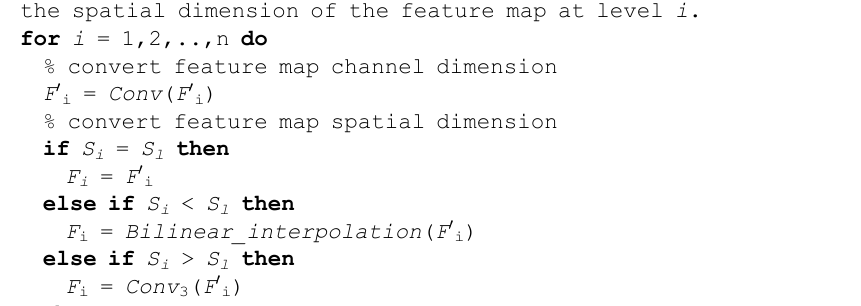
Algorithm 1: The input preparation process for level l of the fusion